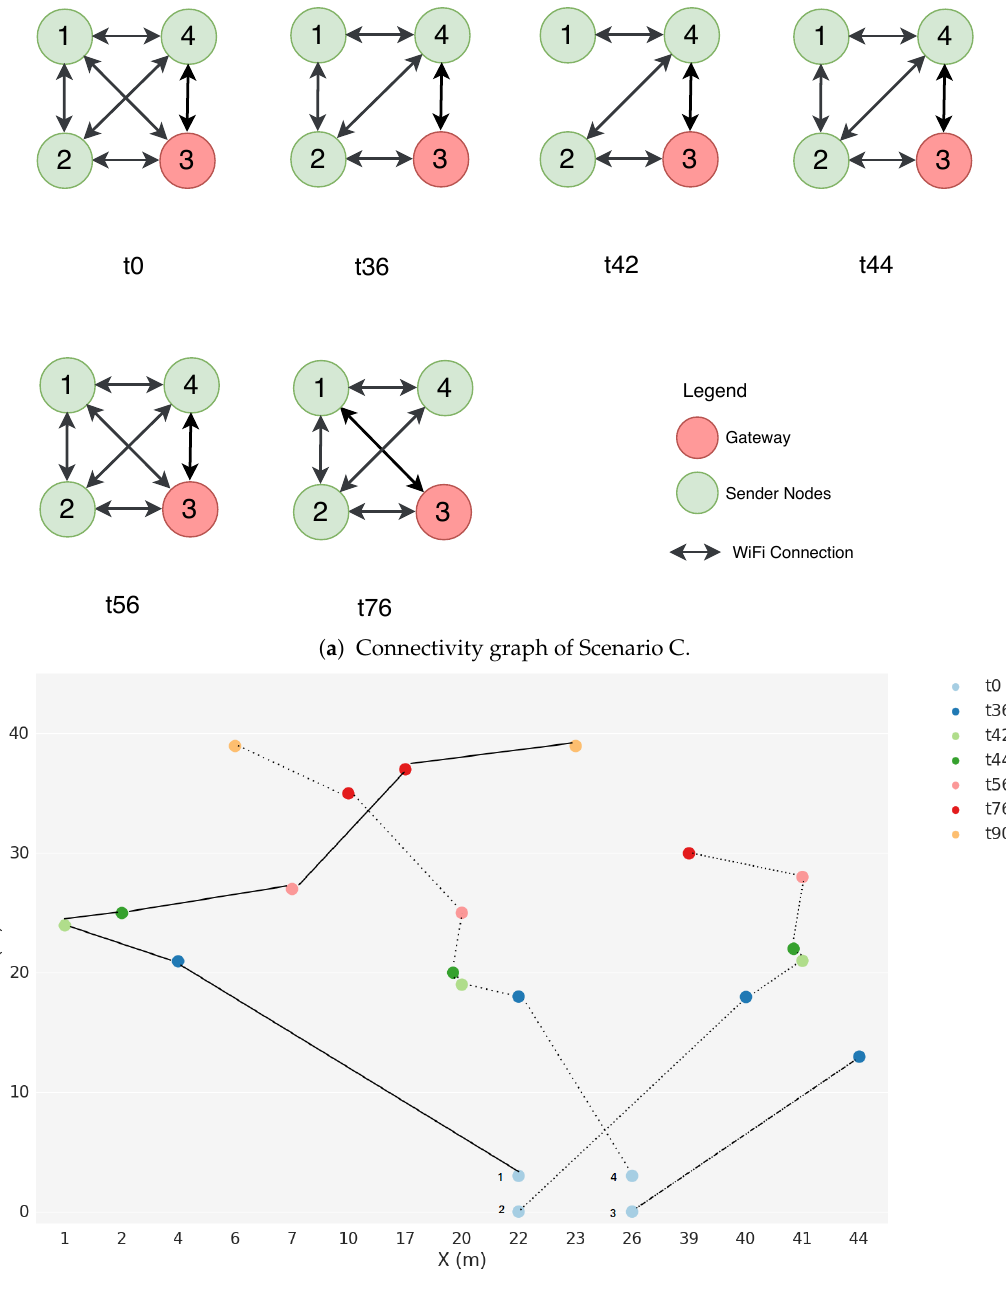
Figure 14. Aquatic Scenario